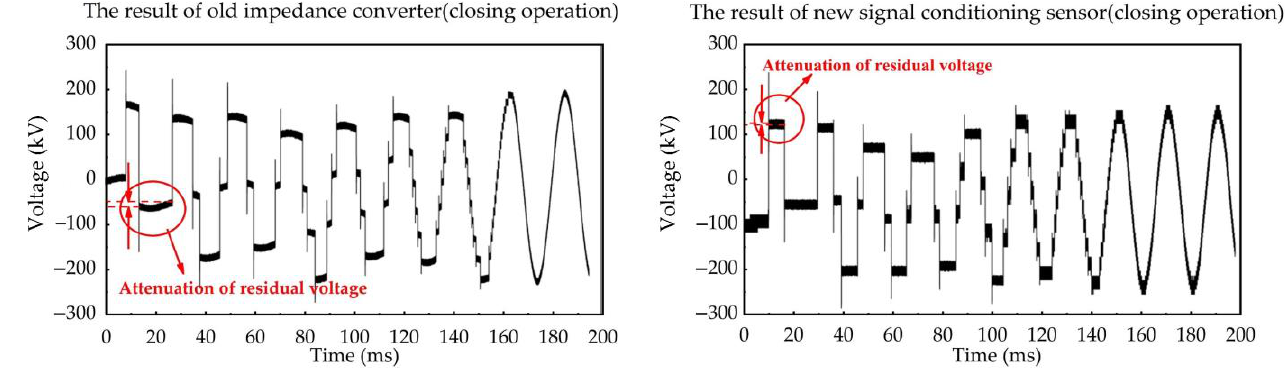
Figure 13. The typical full-time waveform of VFTO measured by the new signal conditioning sensor and the old impedance converter during closing operation.